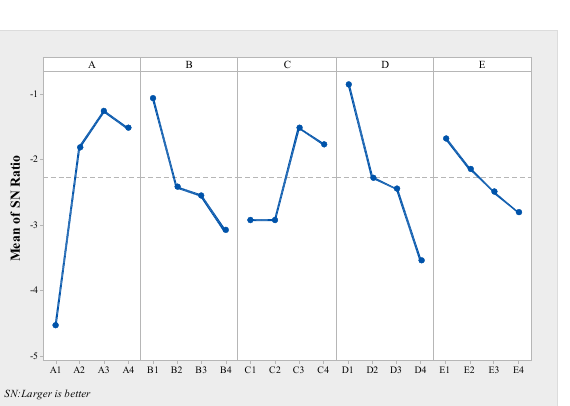
Figure 34. The effect of each design factor on h mass. Figure 34. The e ff ect of each design factor on h mass. Table 6. Factorial effect of Fr.